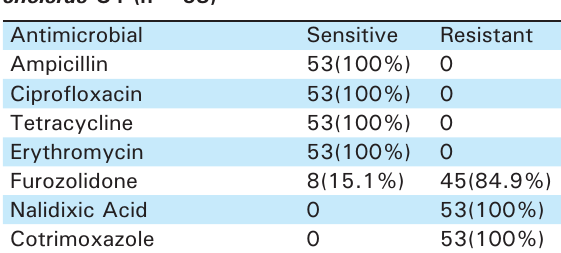
Figure 1. Seasonal distribution of V. cholerae Table 4. Antibiotic susceptibility pattern of Vibrio cholerae O1 (n=